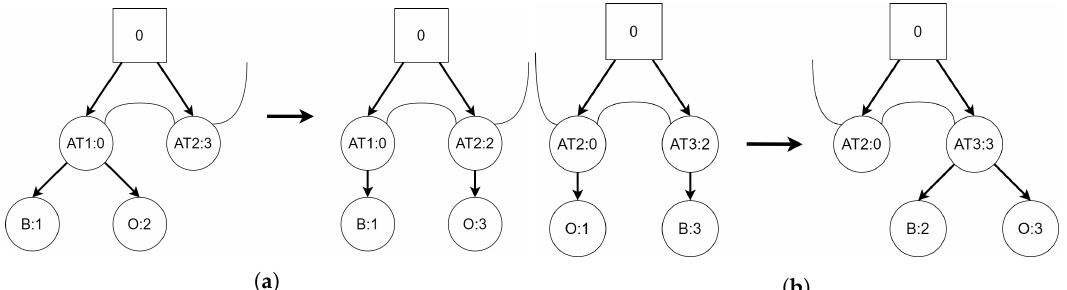
Figure 5. Reaction rules for the example of verifying a model. All residue functions are identities. ( a ) Reaction rule mov 1. ( b ) Reaction rule mov